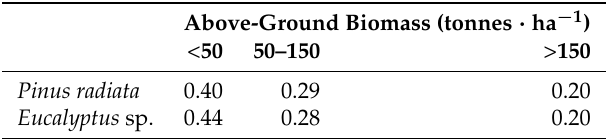
Table 2. Ratio of below-ground biomass to above-ground biomass (Adapted from